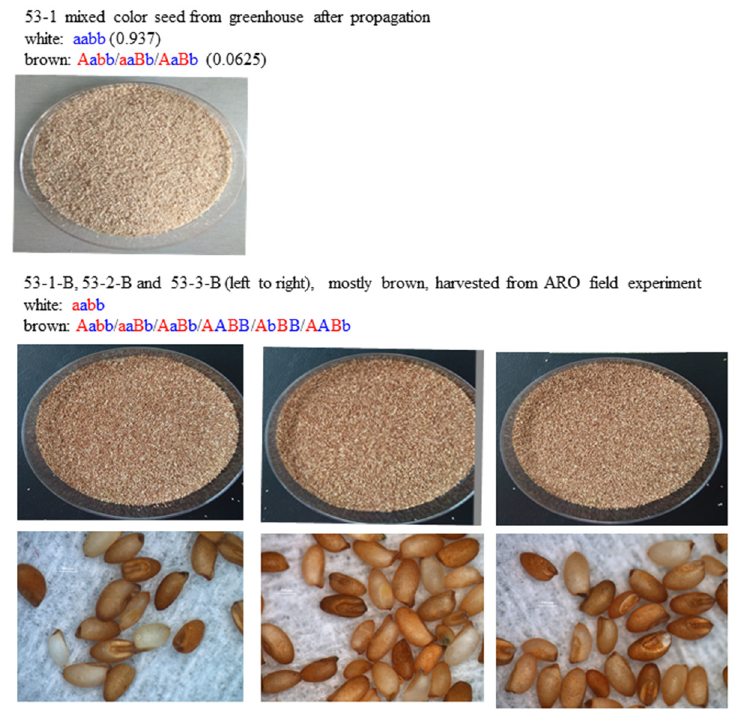
Figure 5. Color segregation in seeds and suggested genotypes.